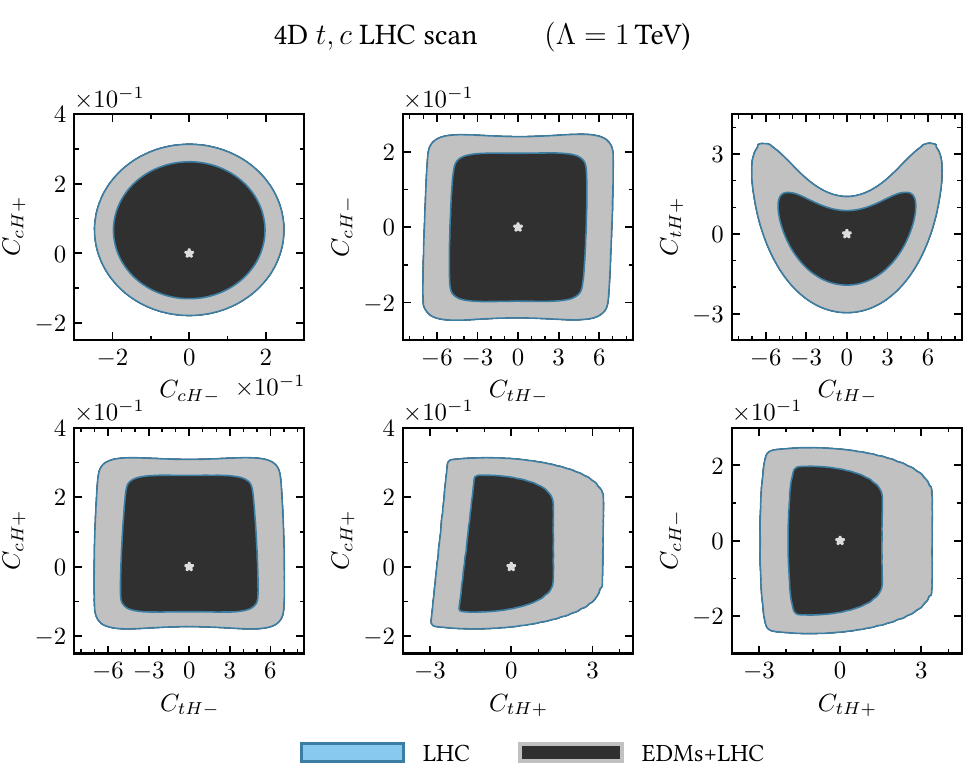
Figure 12 . LHC constraints resulting from a 4D scan of top and charm Wilson coefficients ( C tH ± , C cH ± ) assuming Λ = 1 TeV. In each plot only two parameters are shown, the remaining ones are profiled over (see main text). Contours represent the allowed 68% and 95% confidence regions, the colour coding of individual constraints is given in the legend, and grey/black areas correspond to the combined regions. For details see main text and the caption of figure